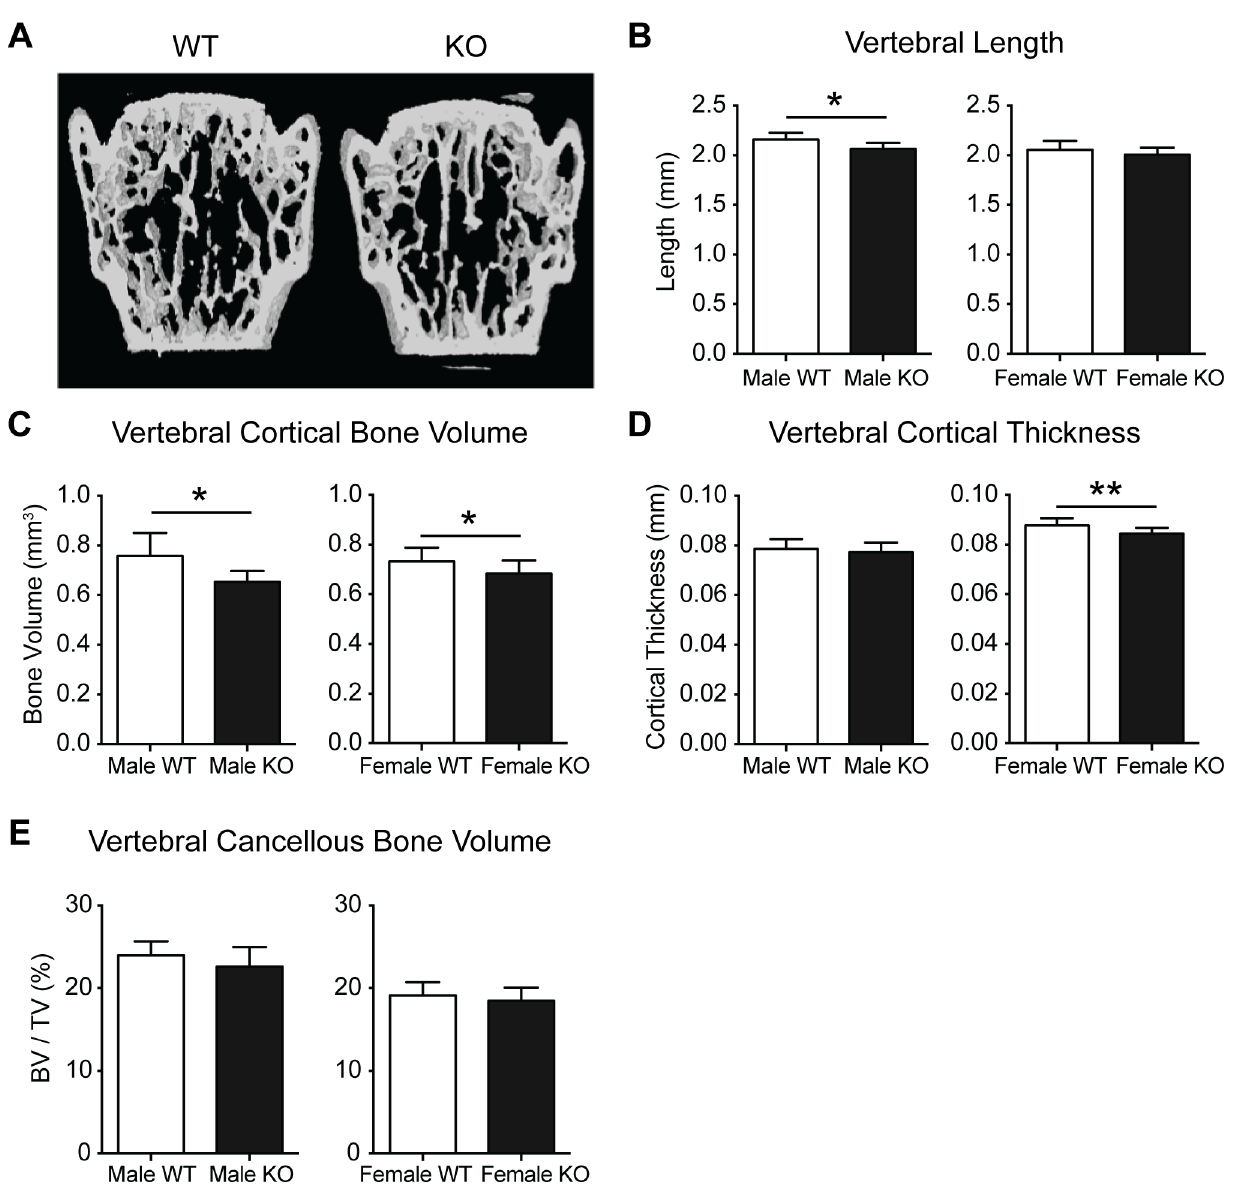
Fig 3. Lumbar vertebral bone analysis of PWCR KO mice. A.) Representative images and micro CT analysis of L3 vertebral bone :- B.) Vertebral length; C.) cortical bone volume; D.) vertebral cortical thickness; E.) cancellous bone volume. n = 7 – 10 represented as mean ± SD. * p-value < 0.05, ** p-value <